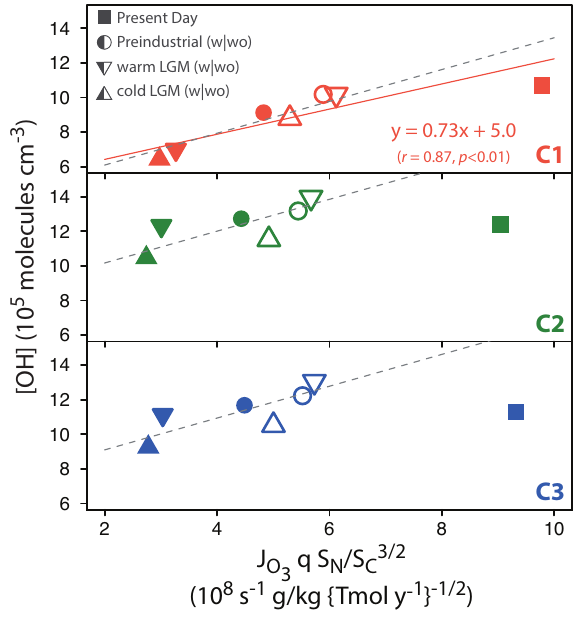
Figure 7. Tropospheric mean mass-weighted OH burden in each (cid:16) (cid:17) q S N / S 3 / 2 simulation as a function of J O , where J O is the C 3 3 tropospheric mean mass-weighted ozone photolysis frequency (s − 1 ), q is the tropospheric mean mass-weighted specific humidity (gkg − 1 ), and S N and S C are the tropospheric sources of reactive ni- trogen (TmolNyr − 1 ) and of reactive carbon (TmolCyr − 1 ), respec- tively. S C is calculated as the sum of emissions of CO, NMVOCs, and an implied source of methane equal to its loss rate by OH. Model results for different chemistry schemes are separated into three subsets as follows. Top panel: original isoprene chemistry and original HO 2 uptake (C1). Middle panel: new isoprene chemistry and original HO 2 uptake (C2). Bottom panel: new isoprene chem- istry and new HO 2 uptake (C3). Different symbols denote differ- ent climate scenarios (present day, preindustrial, warm LGM, cold LGM). Filled symbols represent simulations in which the CO 2 sen- sitivity of plant isoprene emission is considered (w); unfilled sym- bols are those without (wo). All present-day simulations were per- formed with CO 2 sensitivity turned on. The orange line shows a reduced major axis regression fit for the C1 subset, with the regres- sion equation and correlation coefficient ( r = 0.87, p < 0.01) inset. We do not find a statistically significant correlation between OH and (cid:17) (cid:16) J O qS N / S 3 / 2 for the C2 ( r = 0.36) and C3 ( r = 0.34) subsets. C 3 When the present-day values are excluded and a multiple regression model is fitted to the remaining ensemble, we find that the three dif- ferent chemistry schemes possess the same values for the slopes of the linear correlation but different values for the intercepts, as shown by the dashed grey lines (see text for